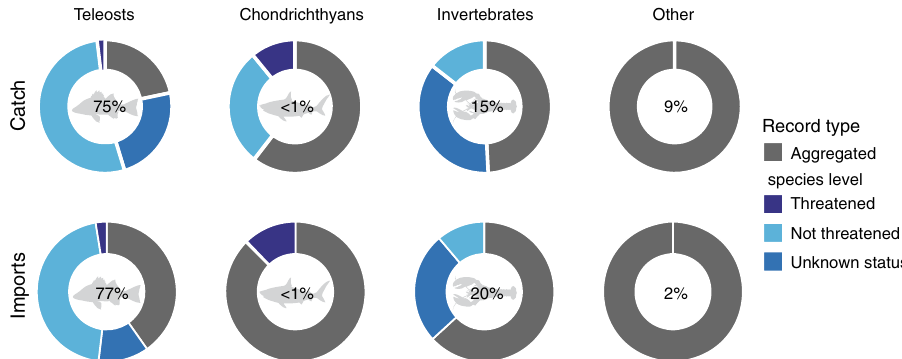
Fig. 2 Taxonomic resolution of catch and import records. Proportions of catch and imports volumes recorded at species level are shown in blue and aggregated records are shown in grey for teleosts, chondrichthyans, invertebrates, and other commodities (e.g. “ marine animals ” ). The number indicates the proportion of total catch or import volume in each taxonomic group over the time period (2006 – 2014 for catch and 2006 – 2015 for imports). Threatened: Critically Endangered, Endangered, or Vulnerable, Not Threatened: Least Concern or Near Threatened, Unknown status: Data De fi cient or has not been assessed, Aggregated: not a species-level record. The fi sh silhouettes are from Freepik.com.